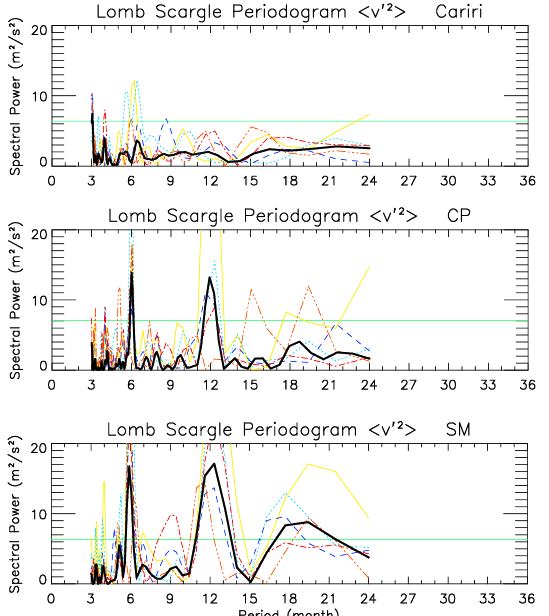
Figure 10. The same as Fig. 9 but for the meridional variance com- ponent.